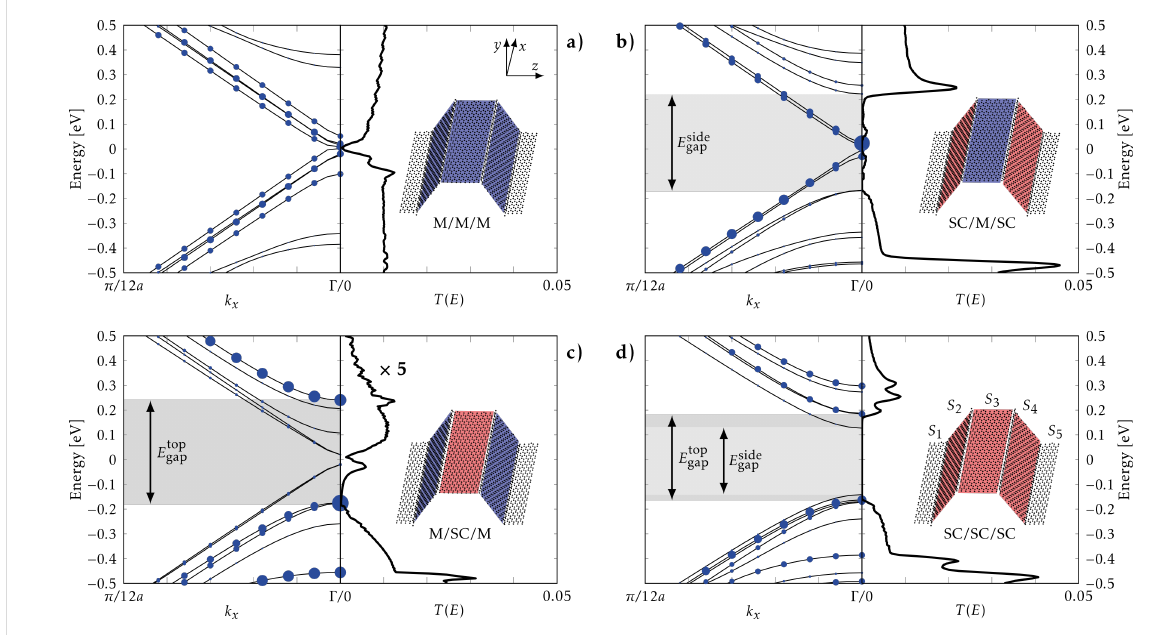
Figure 5: Projected band structure and transmission through structures with multiple kinks. The top (section S 3 ) and connecting pseudo-ribbons (sections S 2 / S 4 ) are varied in width, changing their electronic properties. The projected band structure along the pseudo-ribbons (i.e., k x ) is shown by using filled circles with radii proportional to the weight on section S 3 . Semimetallic (M) pseudo-ribbons corresponding to N = 17 are shown in blue, while semiconducting (SC) ribbons of width N + 1 are shown in red. Band gaps of the top sections and connecting sections are high- lighted. These are = 0.39 eV (b), = 0.42 eV (c), and = 0.35